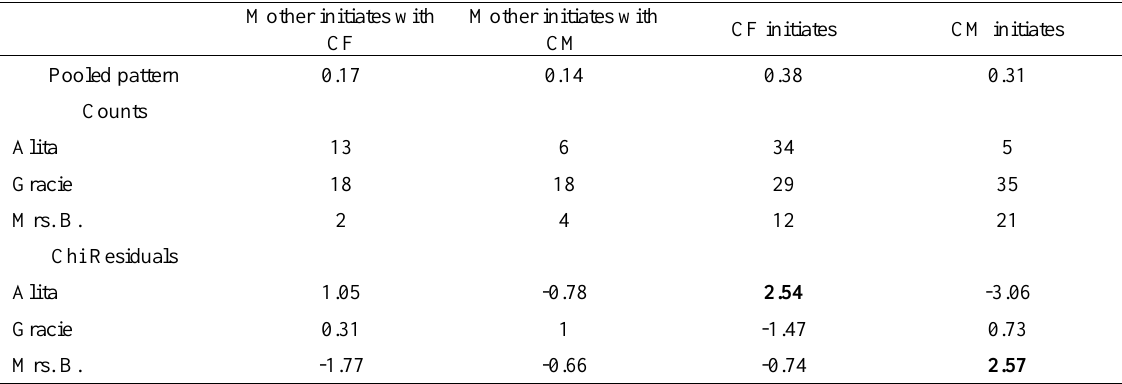
Frequency of Contact for Three Dolphin Mothers and Their Female and Male Calves in the Role of Initiator of Pectoral